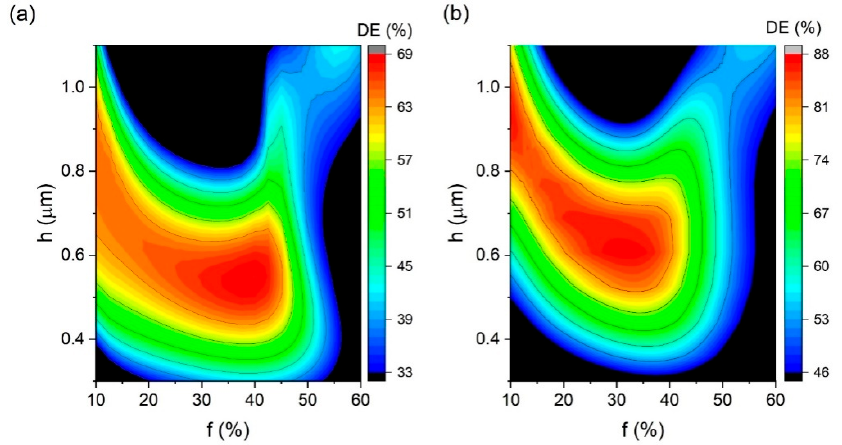
Figure 6. ( a ) Calculated GaAs diffraction efficiency (DE) as a function of groove depth h and filling factor f without ARC and ( b ) Calculated GaAs diffraction efficiency (DE) as a function of groove depth h and filling factor f with h 2 = 410 nm thick n AR and 3 THz phase-matching frequency.